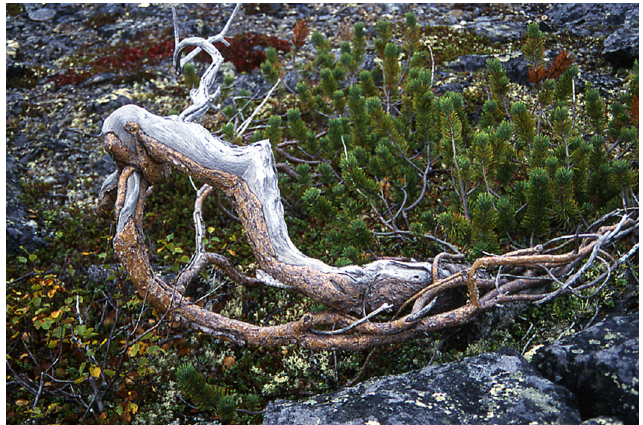
Figure 16. Scots pine ‘krummholz’ ( Pinus sylvestris ; Ø 13cm, >100 years old) of which the bark on the upper stem side projecting above the winter snowpack has been gnawed off by mountain hare ( Lepus timidus ). Jesnalvarri (northern Finland) at 325 m. Photo taken by the author, 15 August